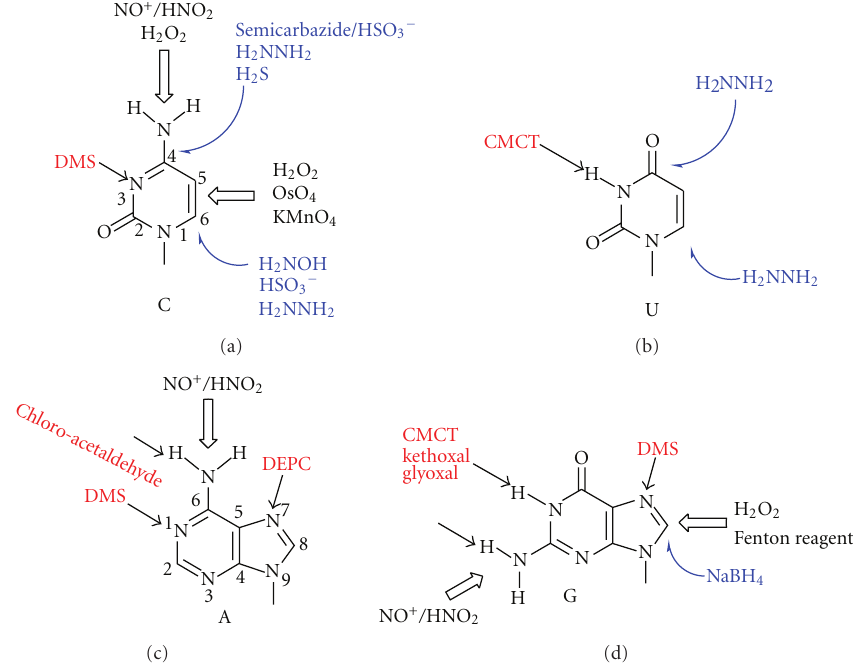
Figure 1: General chemical reactivity of nucleobases. Attack sites on the nucleobase are indicated by arrows. Open black arrows indicate oxidizing agents, filled black ones indicate alkylating electrophiles, and blue ones indicate nucleophiles. Numbering of the nucleobase atoms 1–6 for pyrimidines or 1–9 for purines is indicated outside the